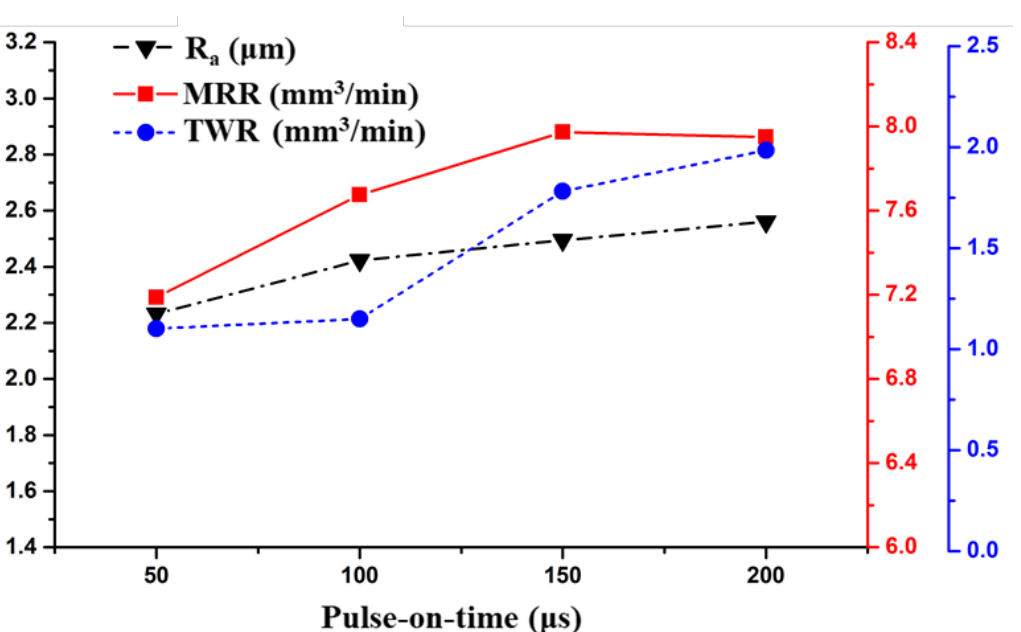
Figure 4. Effect of the Pulse-on-time on the Responses.